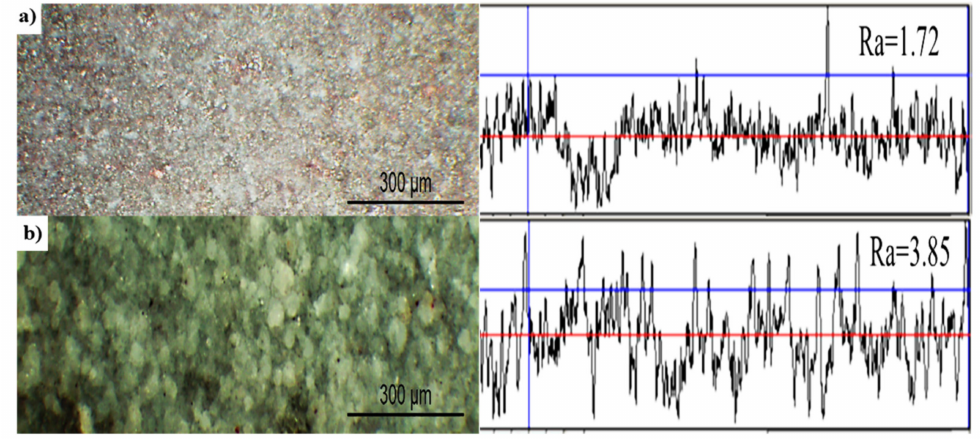
Figure 5. Relief and surface roughness micrographs of A80-P10 ( a ) and A90-P0 ( b ) coatings.